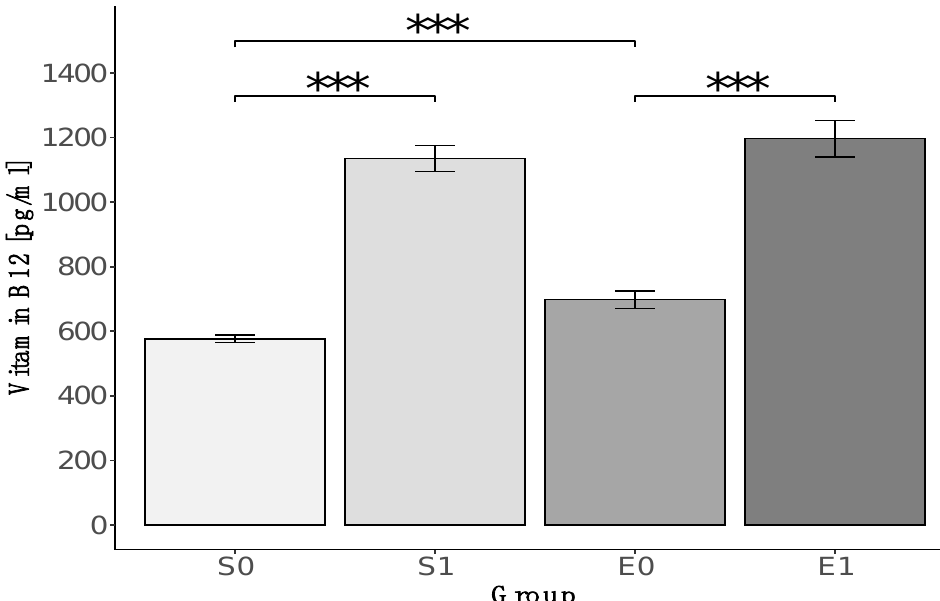
Figure 4. The vitamin B 12 concentration in blood in strength (S) and endurance (E) athletes, who either declared the use of vitamin B 12 injections (S1 and E1) or no use of injections (S0 and E0); *** p < 0.001. In 53 athletes (11 endurance and 42 strength), in whom plasma vitamin B 12 concentrations were determined both without and after the use of injections, a significantly higher Hb and Hct were found only in the endurance group ( p < 0.05; Figure 5).